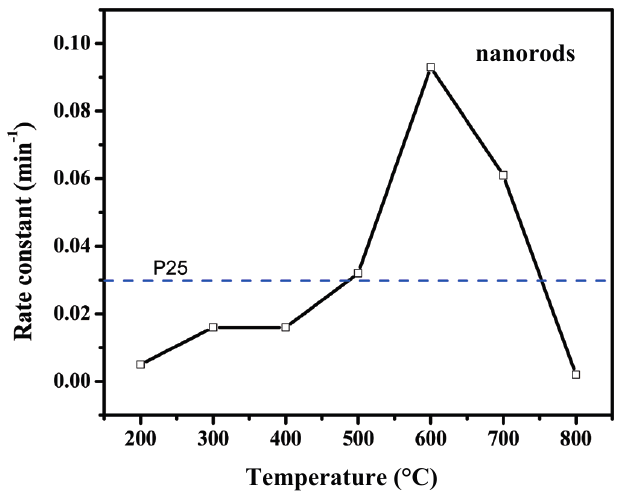
Figure 5. Pseudo-first-order rate constant of CH 3 CHO removal against the calcination temperature T c of TNT with reference to P25 TiO 2 . At T c > 400 °C, the tubular morphology collapsed. Reproduced with permission from reference